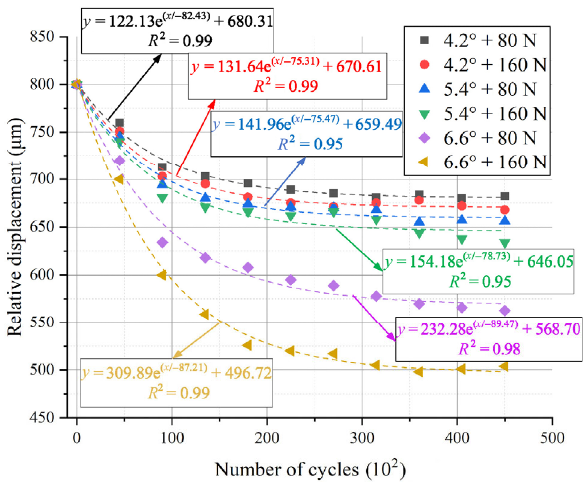
Fig. 14 Evolution trends of relative slip under oil